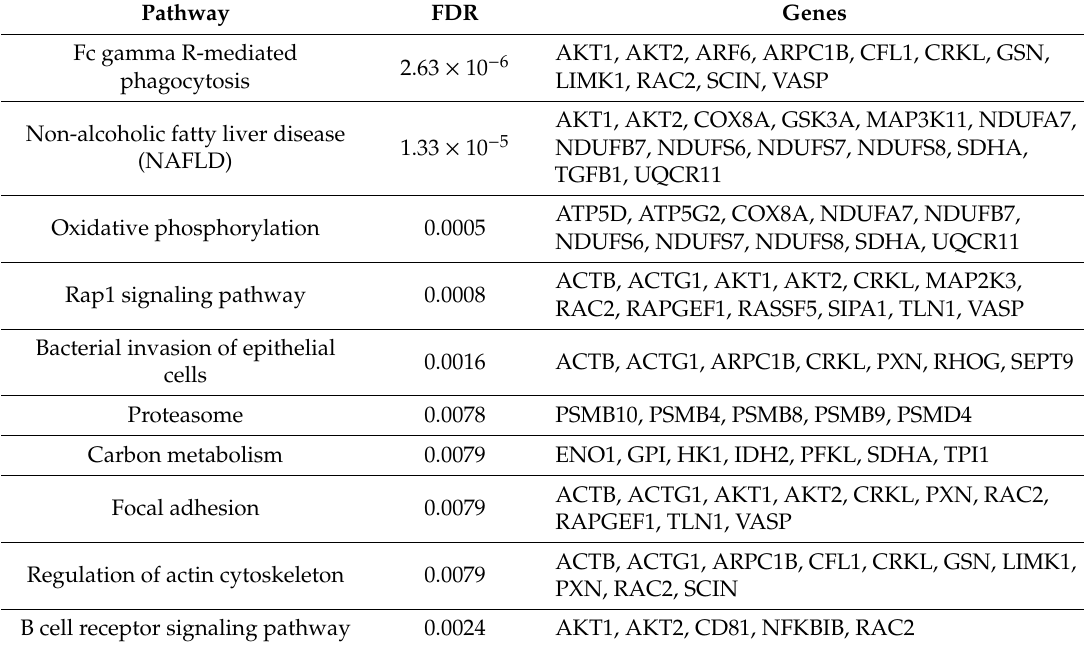
Table 3. List of significantly enriched pathways obtained using the upregulated genes following iodine supplementation.